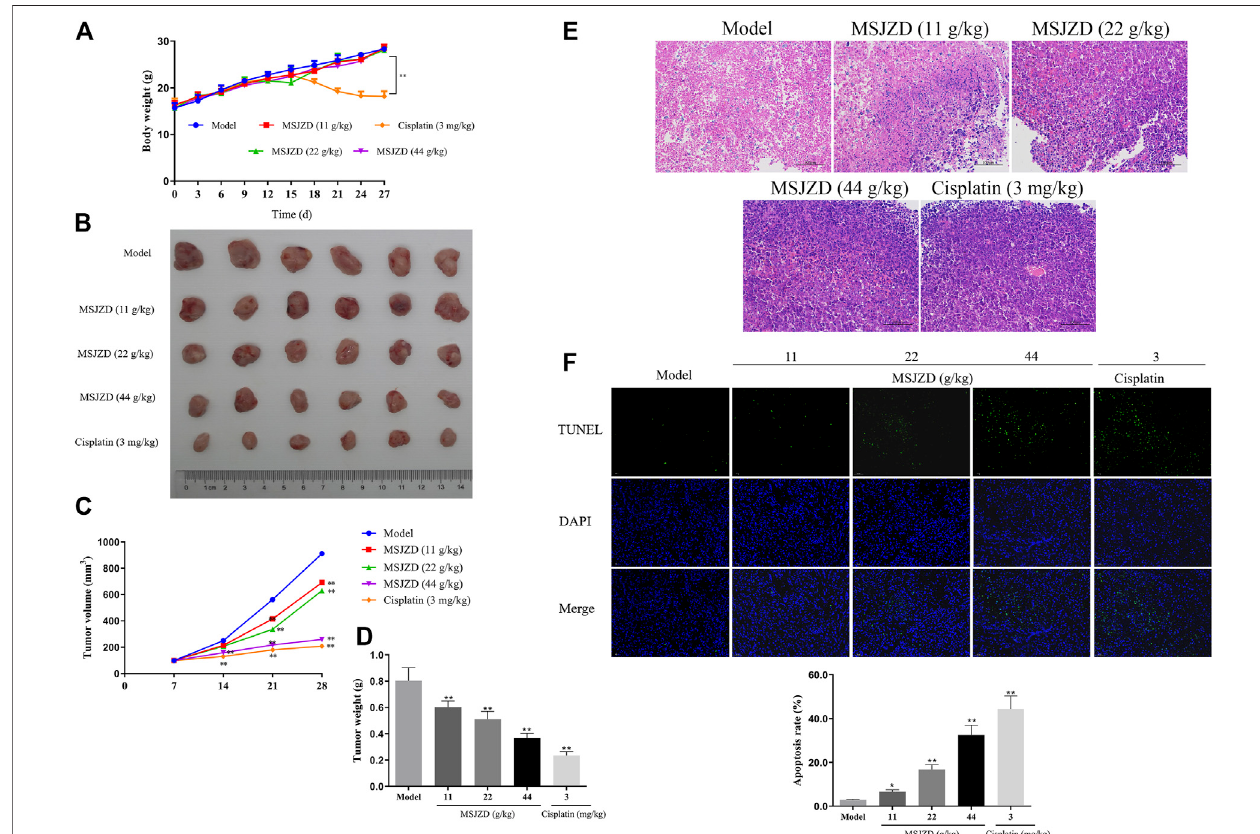
FIGURE7| MSJZDattenuatedthetumorgrowth,promotedhistopathologicaldamage,andinducedapoptosisinA549tumor-bearingnudemice. (A) Bodyweight of mice after MSJZD treatment was determined every 3 days. (B) Photograph of subcutaneous xenografts in A549 tumor-bearing nude mice after 28 days of treatment of MSJZD. The volume (C) and weight (D) of xenografts in MSJZD and Cisplatin groups. (E) Microscopic images of xenografts were observed by H&E staining. (F) TUNEL assay was performed to assess the apoptosis rate of xenografts in MSJZD and Cisplatin groups. * p < 0.05, ** p < 0.01. versus the model group.